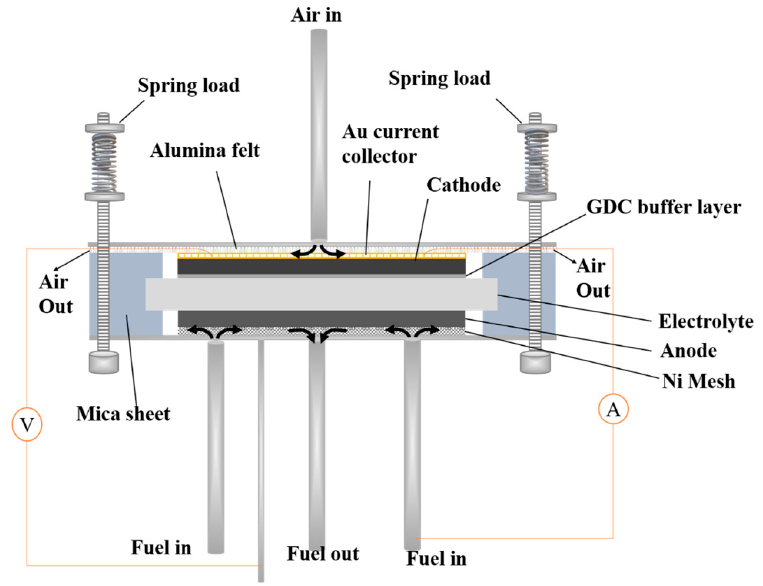
Figure 2. Schematic diagram of Fiaxell fuel-cell setup and assembly.